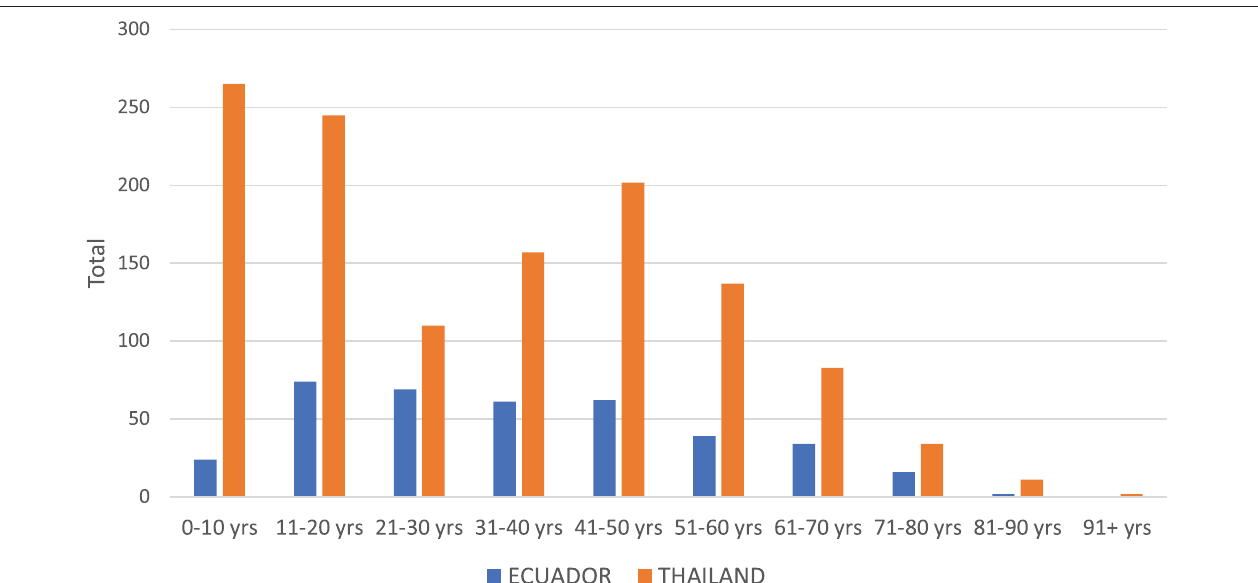
FIGURE 2 | Histogram of ages of enrolled Associates in Thailand (orange) and Ecuador (blue).